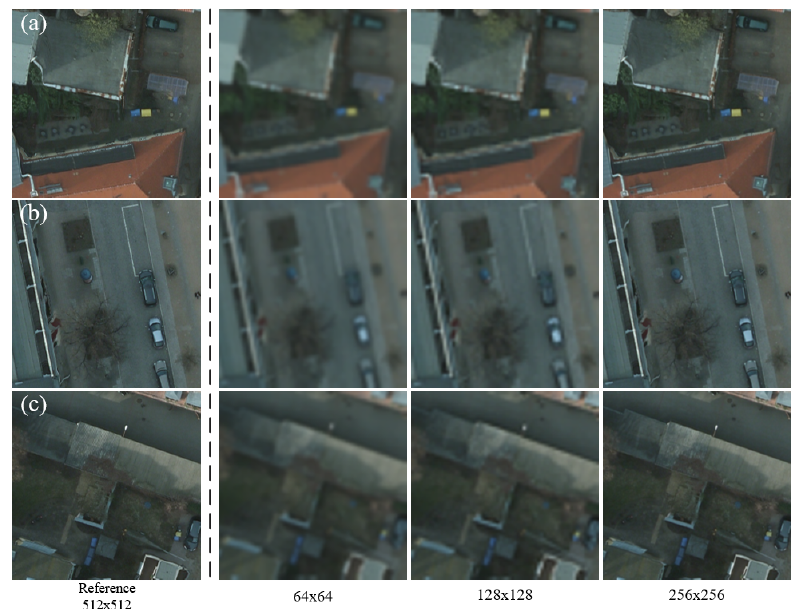
Figure 3. Visualized (×8, ×4, ×2) SR reconstructions of the ISPRS-Potsdam dataset. ( a – c ) are some samples from the ISPRS-Potsdam dataset. From left to right are 512 × 512, 64 × 64, 128 × 128 and 256 × 256. Among them, the 512 × 512 HR remote sensing images are obtained by cropping, and the remaining LR images are obtained by downsampling. Zoom-in for better